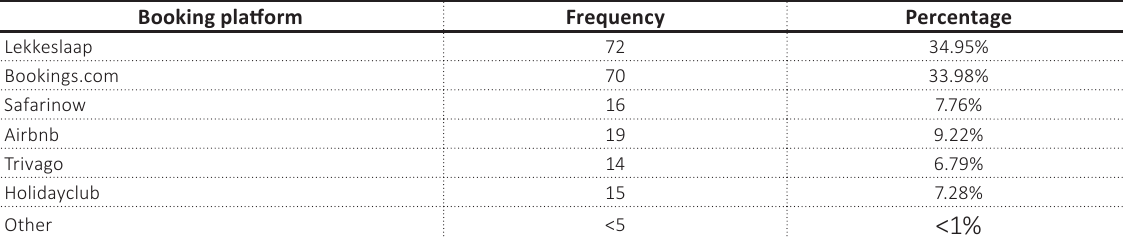
Table 2. Top online booking